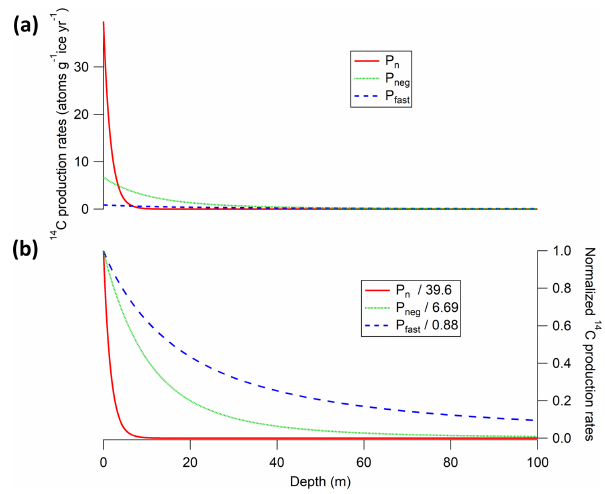
Figure 1. (a) In situ cosmogenic 14 C production rates scaled for the Taylor Glacier study site (77 ◦ 44 (cid:48) S, 162 ◦ 10 (cid:48) E; 526m elevation) from the three nuclear mechanisms, i.e., nucleon-induced spalla- tion ( P n ), negative muon capture ( P neg ), and fast muon interactions ( P fast ). (b) Depth profiles of the three production mechanisms nor- malized to their respective surface production rates (the respective surface production rates are shown in the legend). For 14 C produc- tion from neutron spallation, we used the surface production rate estimate from Young et al. (2014) with scaling from the Lifton et al. (2014) LSDn model. For the two muon mechanisms (neg- ative and fast muons), we used the production rate model from Balco et al. (2008), which follows parameterizations by Heisinger et al. (2002a,